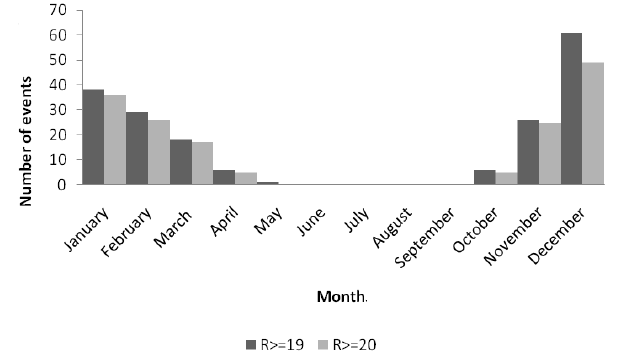
Fig. 2. Monthly occurrence of heavy rainfall events.